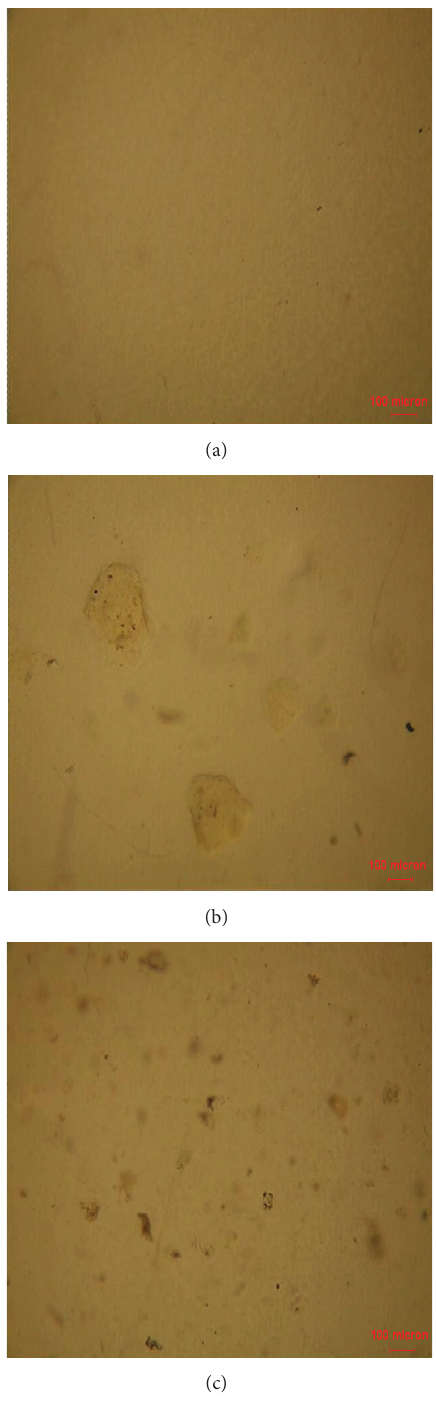
Figure 5: SEM images of etched film (a) neat PP, (b) PP/Oil-g- CF composite, and (c) PP/Silane-g-CF composite at 4.0 wt% filler loading (scale bar 10 𝜇